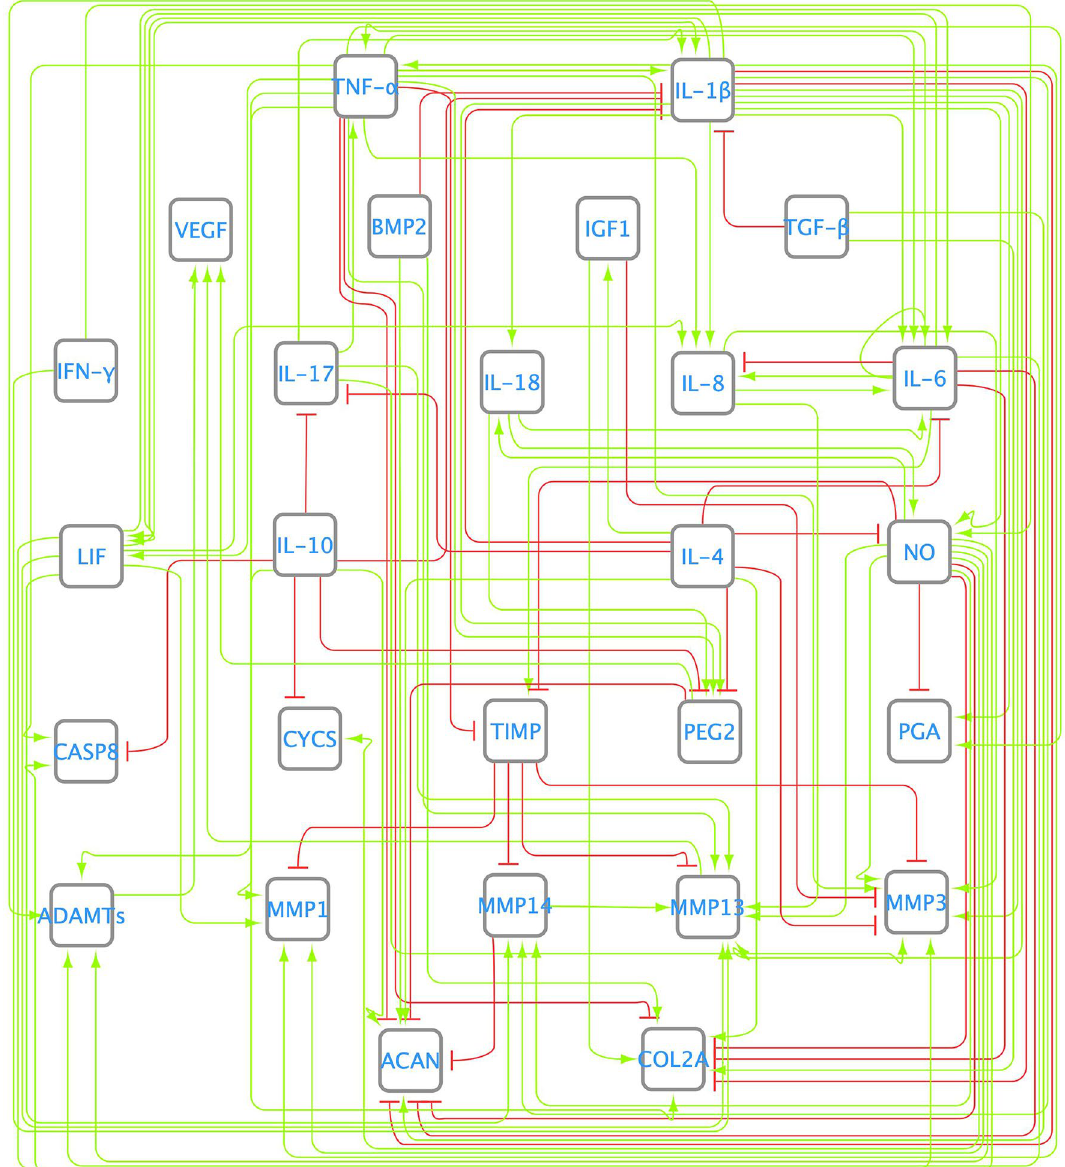
Figure 2. Literature-based network (LIT). Nodes of the network correspond to the most relevant osteoarthritis- related molecules. Nodes are interconnected with each other with a set of activating (green) and inhibiting (red) links or edges. The summarized connectivity can be seen in Additional Material 1 A1 Table